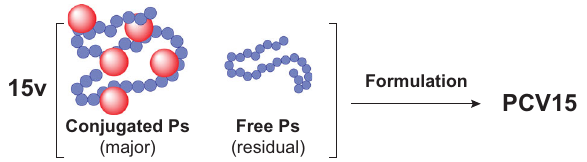
Fig. 1 PCV15 vaccine product. CRM197 protein-conjugated poly- saccharide (Ps) is the major antigenic form, and that unconjugated free Ps is a minor form. In PCV15 vaccine, 15 types of conjugate and free polysaccharides are formulated together.